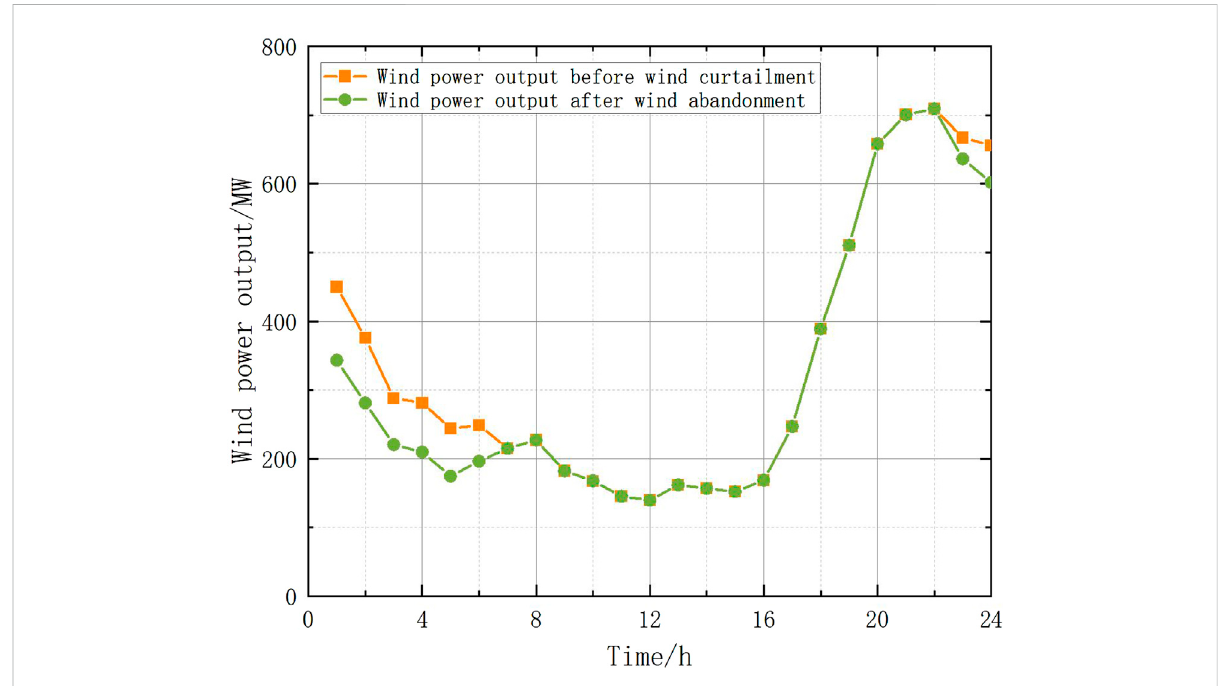
FIGURE 8 Wind power output curve before and after reasonable wind curtailment.